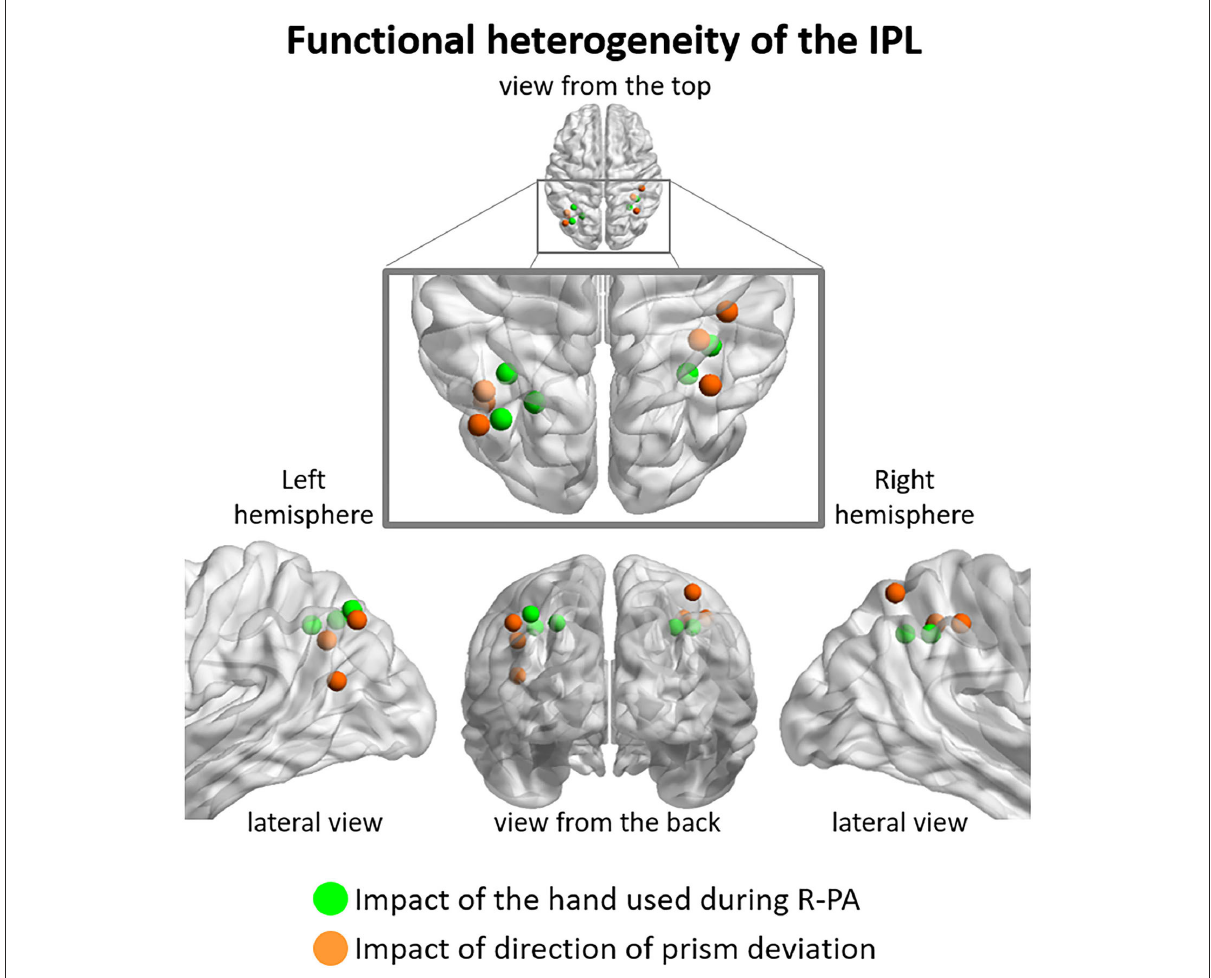
FIGURE4 Functional heterogeneity of IPL, as revealed by the impact used during R-PA vs . (green dots), the direction of prism deviation (orange dots). The former correspond to peaks of activity determined by three-way ANOVA Group (RWRH, RWLH) x Target location (left, center, right) x Session (pre, post) illustrated in Figure 2, the latter to those of two-way ANOVA Group (RWRH, LWRH) x Session (pre, post) illustrated in Figure 3. Note that in the left hemisphere regions impacted by the hand used during R-PA are located in the supero-medial part of IPL and those impacted by the direction of the prism deviation in the latero-posterior part. Less clear segregation is present in the right